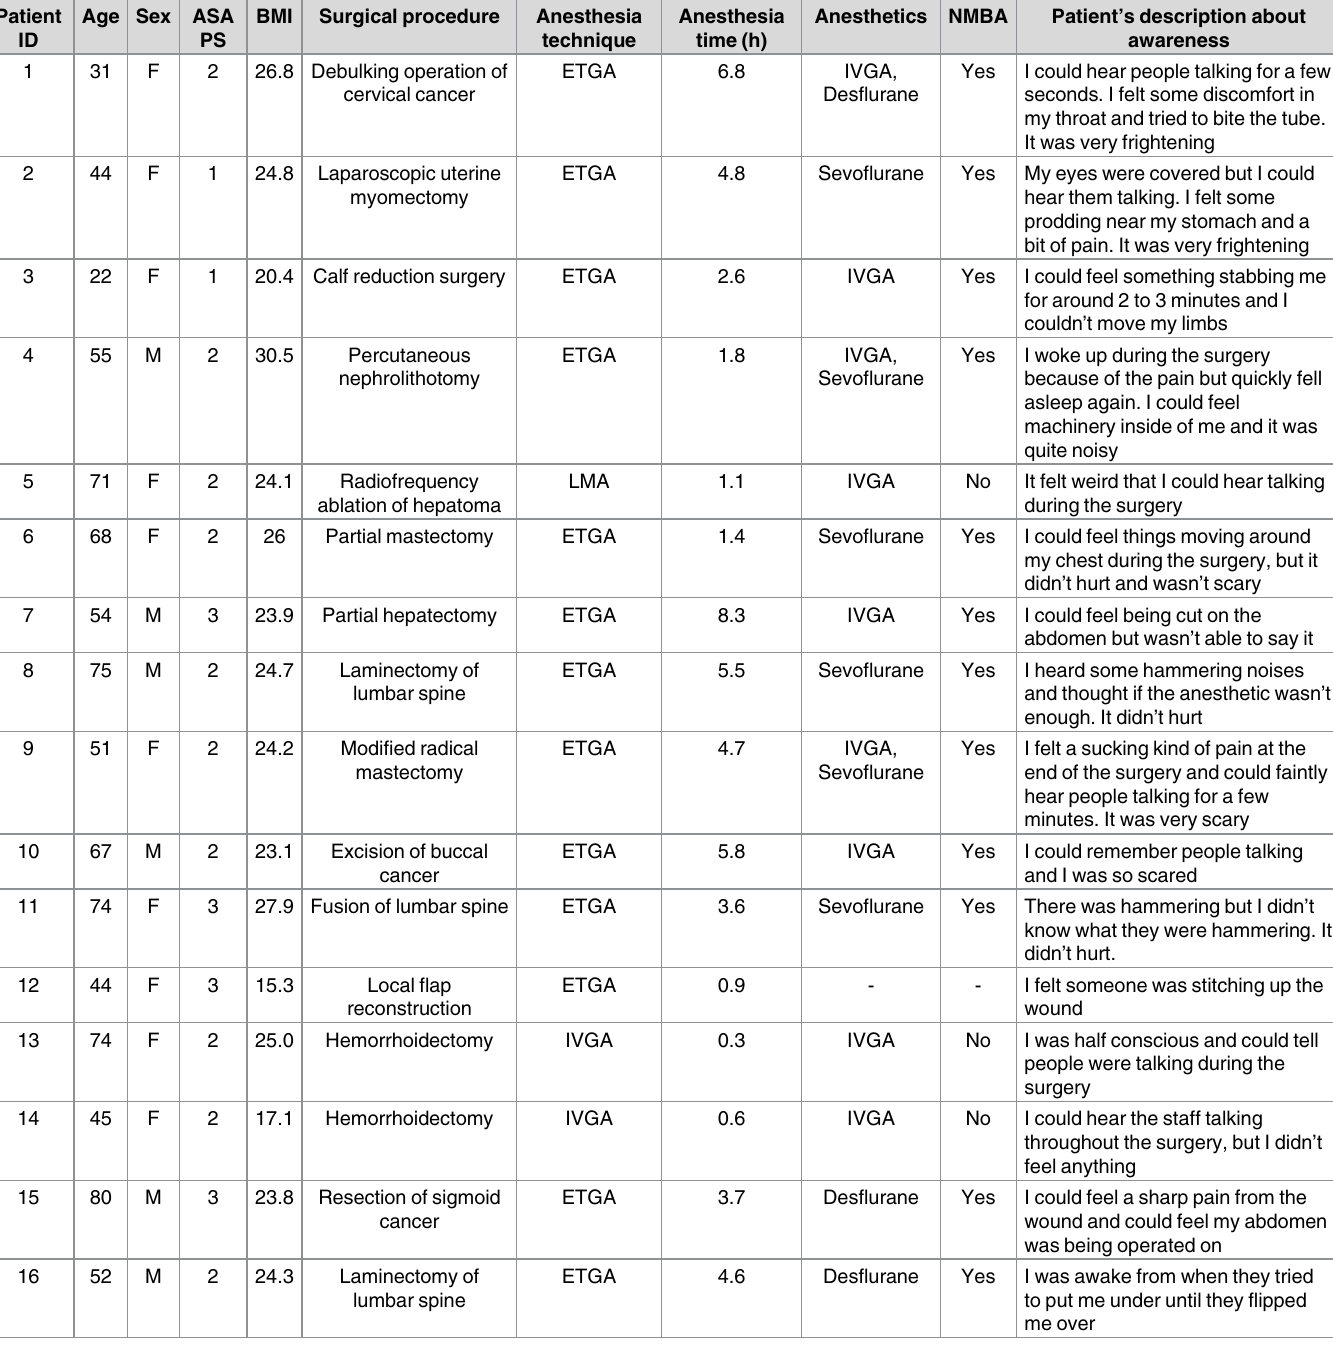
Table 1. Characteristics and descriptions of intraoperative